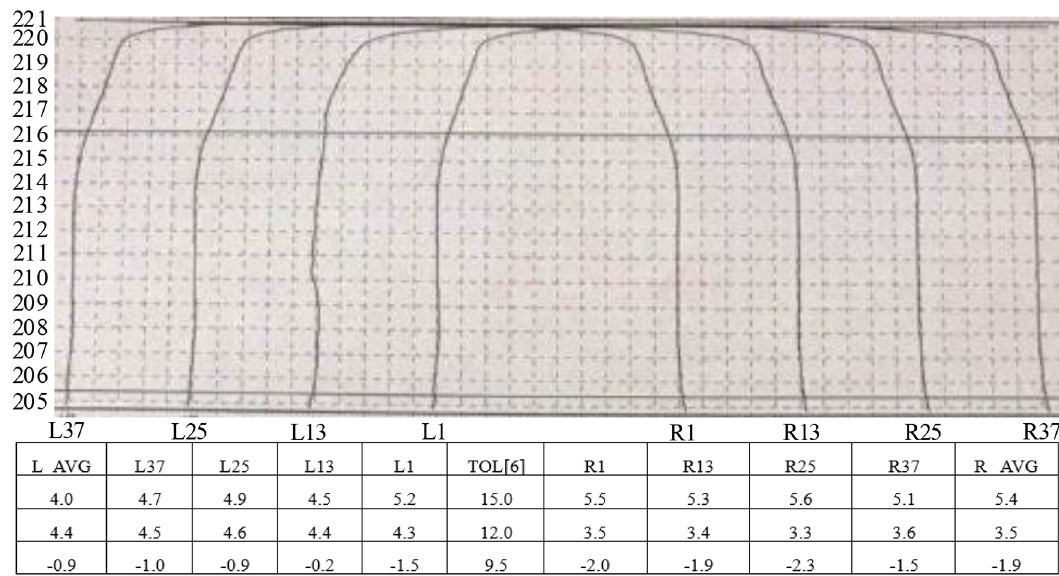
Fig. 8. Pro fi le measurement curve of